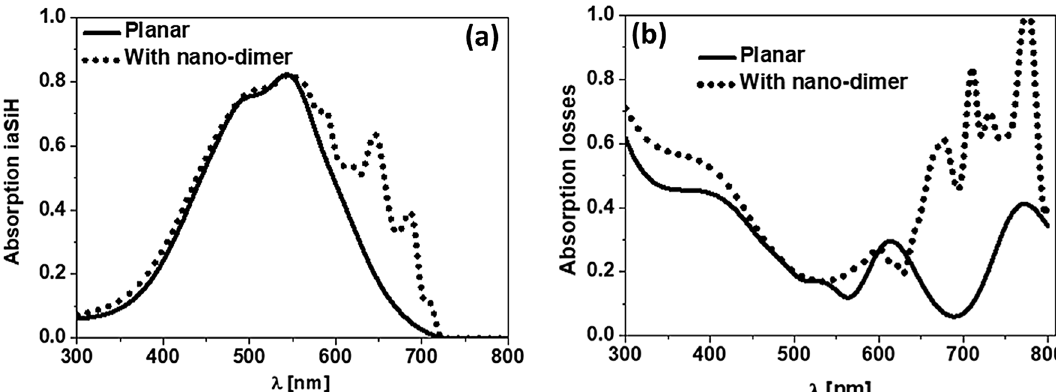
Figure 6. ( a ) Spectral absorption at the active i-aSi:H layer for the planar cell (solid black line), and the cell with dimers (dotted black line). ( b ) Spectral absorption at the auxiliary and buffer layers of the cell (absorption losses), for the planar cell (black solid line), and cell with dimers (black dotted line).